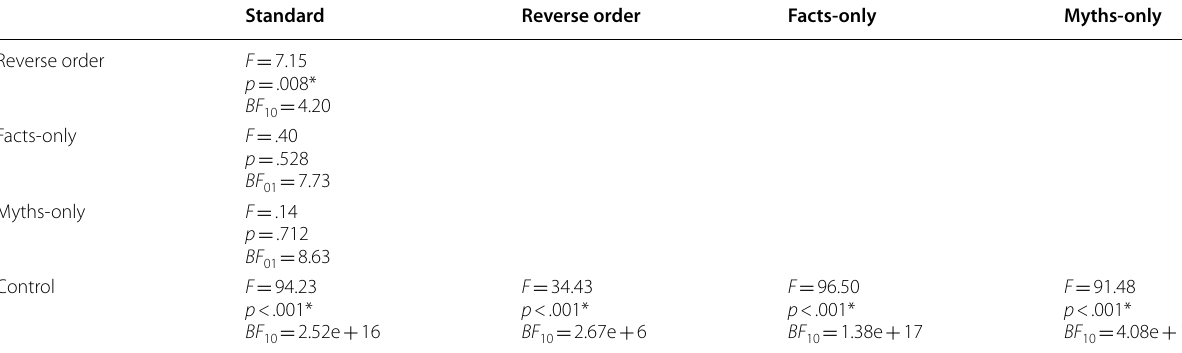
All df1 1, df2 195; * indicates significance after Holm–Bonferroni correction = =